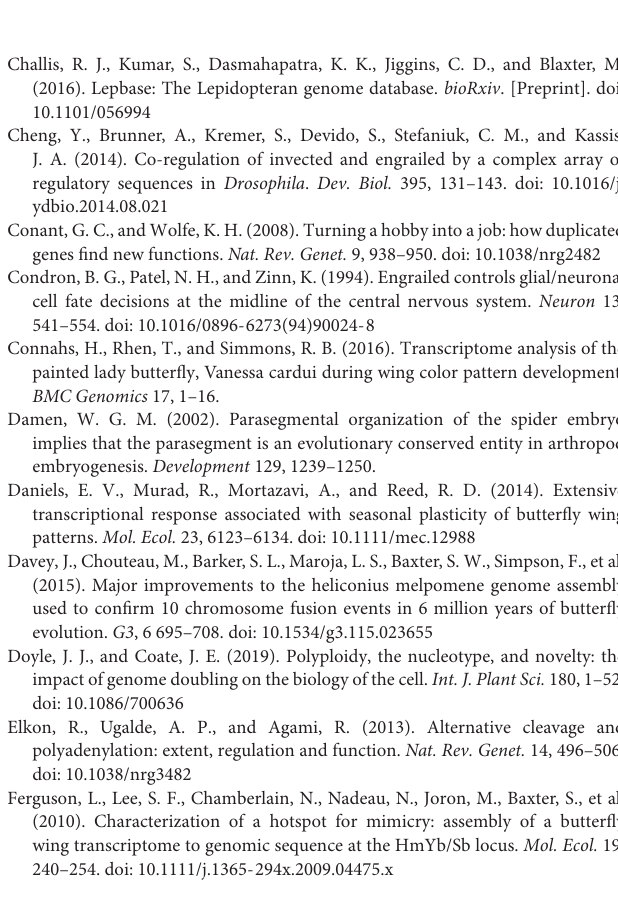
Vertical lines indicate mean number of amino acid substitutions per site. Numbers above branches represents branch support. FIGURE S4 | Phylogenetic tree of En-family proteins in Lepidoptera created using Geneious tree builder (Jukes-Cantor as the genetic distance model, and UPGMA as tree build method). The tree clusters En together; and Inv and Inv-like together. Numbers above branches represent branch support calculated based on 1000 bootstraps. FIGURE S5 | DNA sequence alignment of en , inv and inv-like and the regions used for probe design. Sequence used for inv probe has 24.9% identical bps to that of the en sequence, and 36.03% identical bps to that of the inv-like sequence. Sequence used for inv-like probe has 30.2% identical bps to that of the en sequence, and 36.8% identical bps to that of the inv sequence. FIGURE S6 | Mapping of en , inv and inv-like in the genome of P. xylostella (pacbiov1). Location of the transcripts was obtained from Lepbase. FIGURE S7 | Mapping of en , inv and inv-like in the genome of H. melpomene melpomene (Hmel2). Location of the transcripts was obtained from Lepbase. TABLE S1 | En scaffold features of B. anynana, H. melpomene melpomene , and P. xylostella. TABLE S2 | Similarity matrix of highly conserved regions (EH4 and EH5) of en , inv and inv-like nucleotide sequences in Supplementary Figure S5 . TABLE S3 | Primer table. TABLE S4 | In situ hybridization buffers. TABLE S5 | Immunohistochemistry